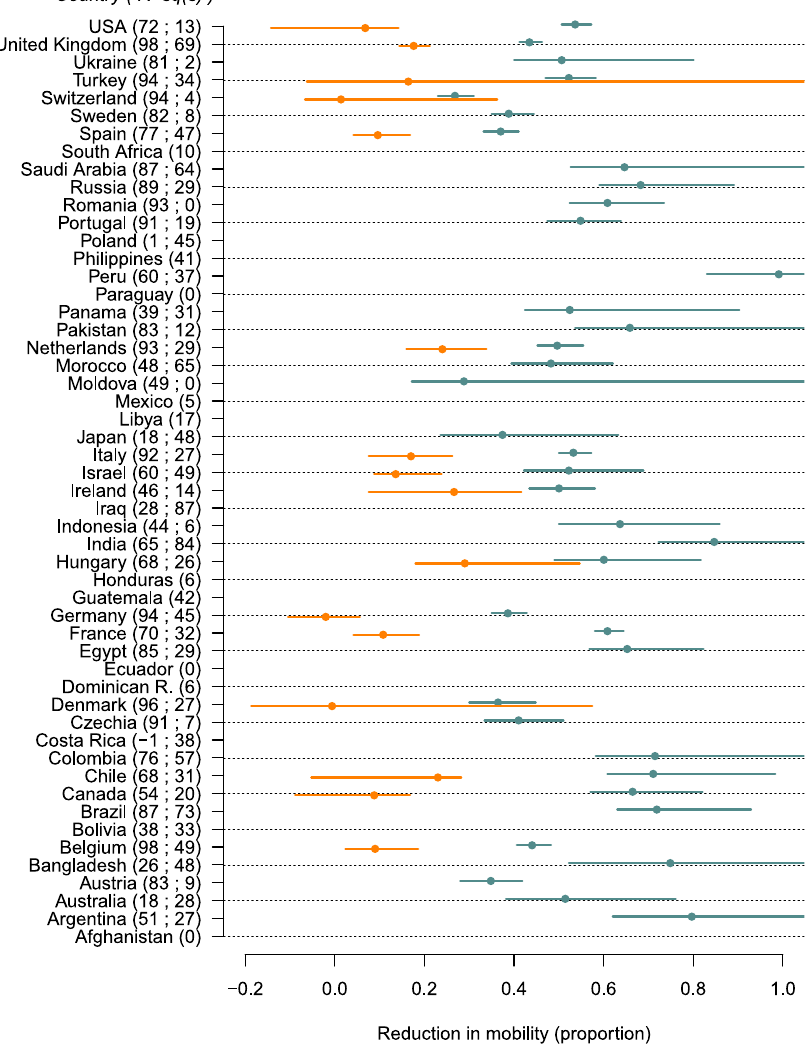
Fig. 4 Country-speci fi c mobility thresholds to interrupt transmission. Interruption of transmission occurs when R < 1, thresholds presented are based on the Apple-Google mobility data-stream. Thresholds are only de fi ned when transmissibility signi fi cantly decreases with a reduction in mobility. Countries with no threshold are still shown. Points indicate the median and horizontal bars the 95% CrI. Upper 95%CrI limits of the mobility going above 1 indicate that the upper limits remain unidenti fi able. Turquoise and orange thresholds correspond to the pre- and post-change in the mobility-transmissibility relationship respectively. The y-axis shows speci fi c countries and, next to their names, the predictive abilities of the model in that country (i.e., adjusted R- squared of R D ; obs t ; i against R D t ; i ; two R-squared values indicate a change in relationship was